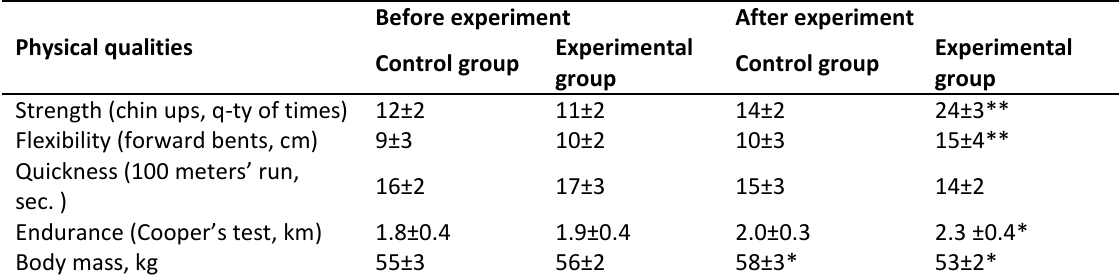
Table 2. Physical condition and physical fitness indicators of the tested girls Physical qualities